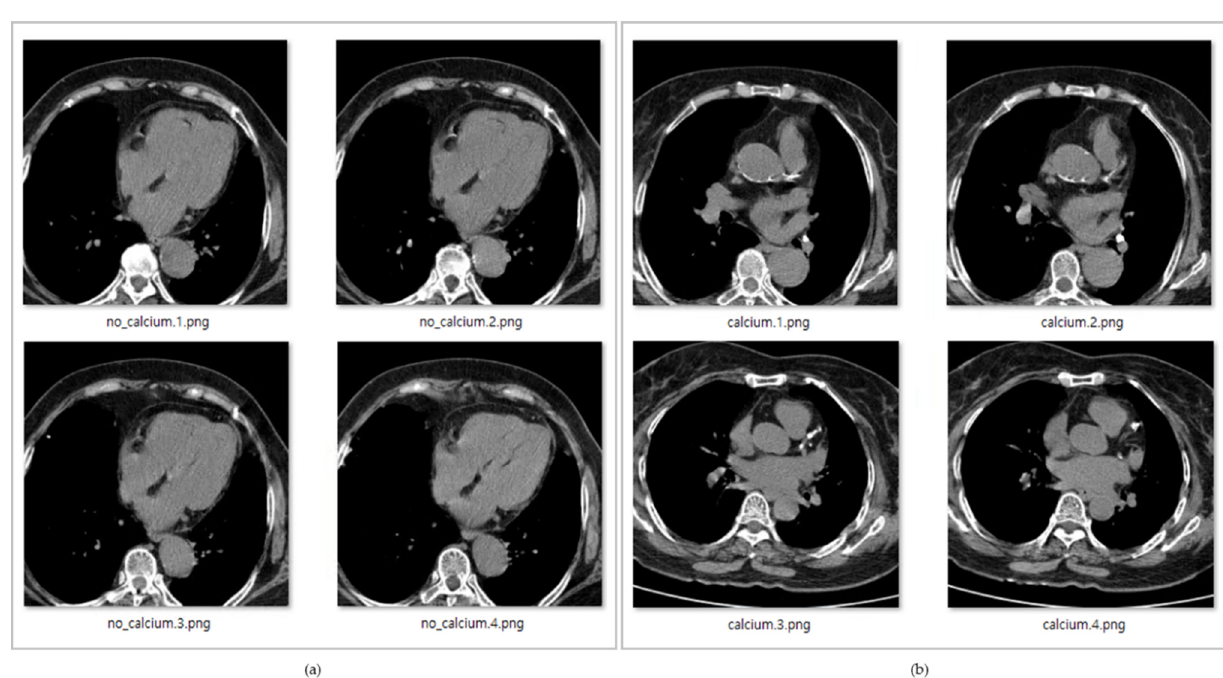
Figure 5. ( a ) Original coronary artery calcium score CT image without calcification, ( b ) Original coronary artery calcium score CT image with calcification.